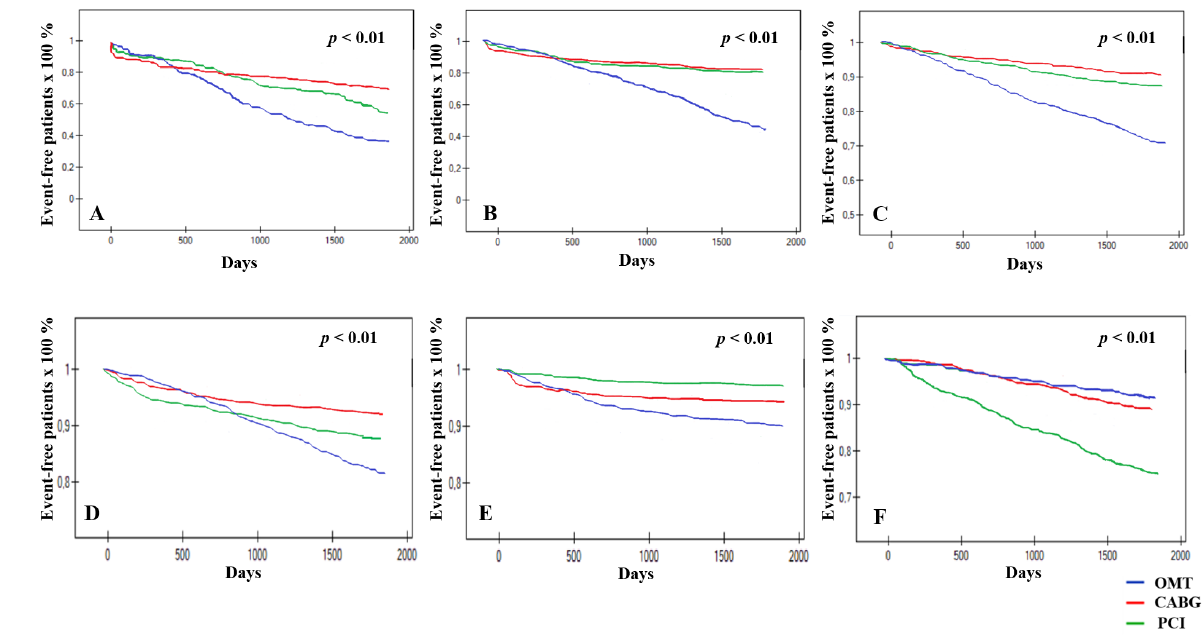
Figure 2. The Kaplan-Meier curves for endpoints. ( A ) — MACCE ( death from any cause, stroke, my- ocardial infarction, or repeat/need for revascularization), ( B ) — all-cause mortality, stroke or myo- cardial infarction (MI), ( C ) — all-cause mortality, ( D ) — MI, ( E ) — stroke, ( F ) — repeat/need for revas- cularization.